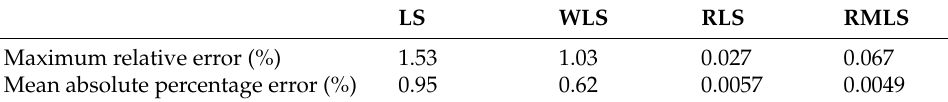
Table 1. Accuracy statistical indices of four algorithms at x = 15 cm (without noise). LS WLS RLS RMLS Maximum relative error (%) 0.020 0.020 0.028 0.032 Mean absolute percentage error (%) 0.0052 0.0052 Table 2. Accuracy statistical indices of four algorithms at x = 15 cm (with noise). LS WLS RLS RMLS Maximum relative error (%) 1.53 1.03 0.027 0.067 Mean absolute percentage error (%) 0.95 0.62 0.0057